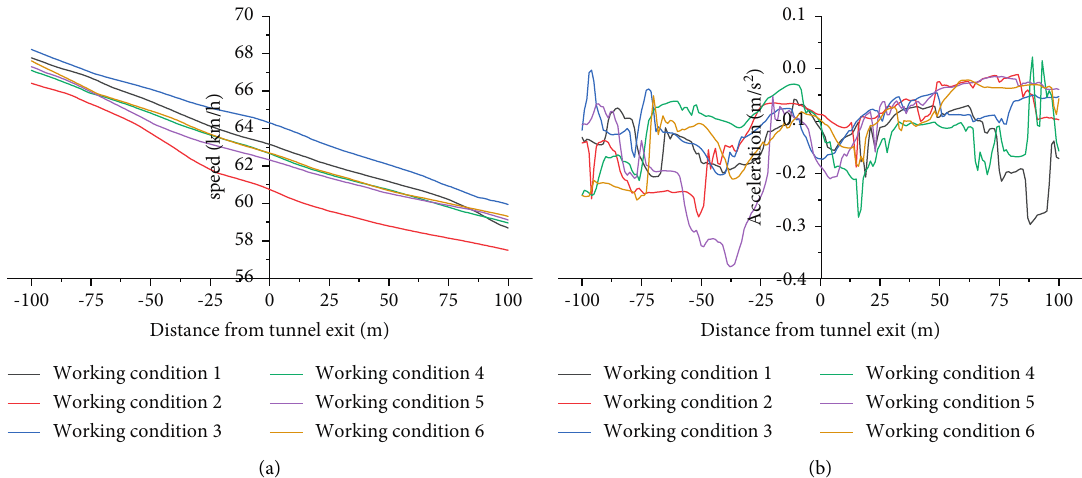
Figure 10: Vehicle speed and acceleration curves within 200m before and after the lane change position in the first service level. (a) Speed curve. (b) Acceleration curve.